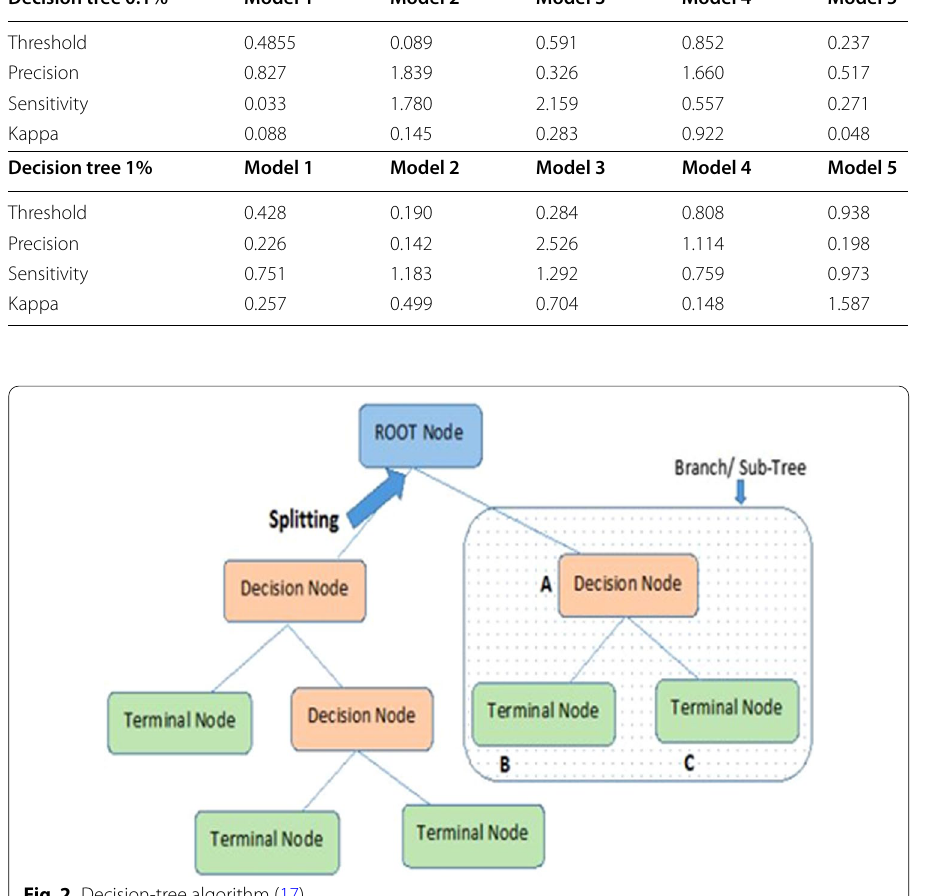
Fig. 2 Decision-tree algorithm